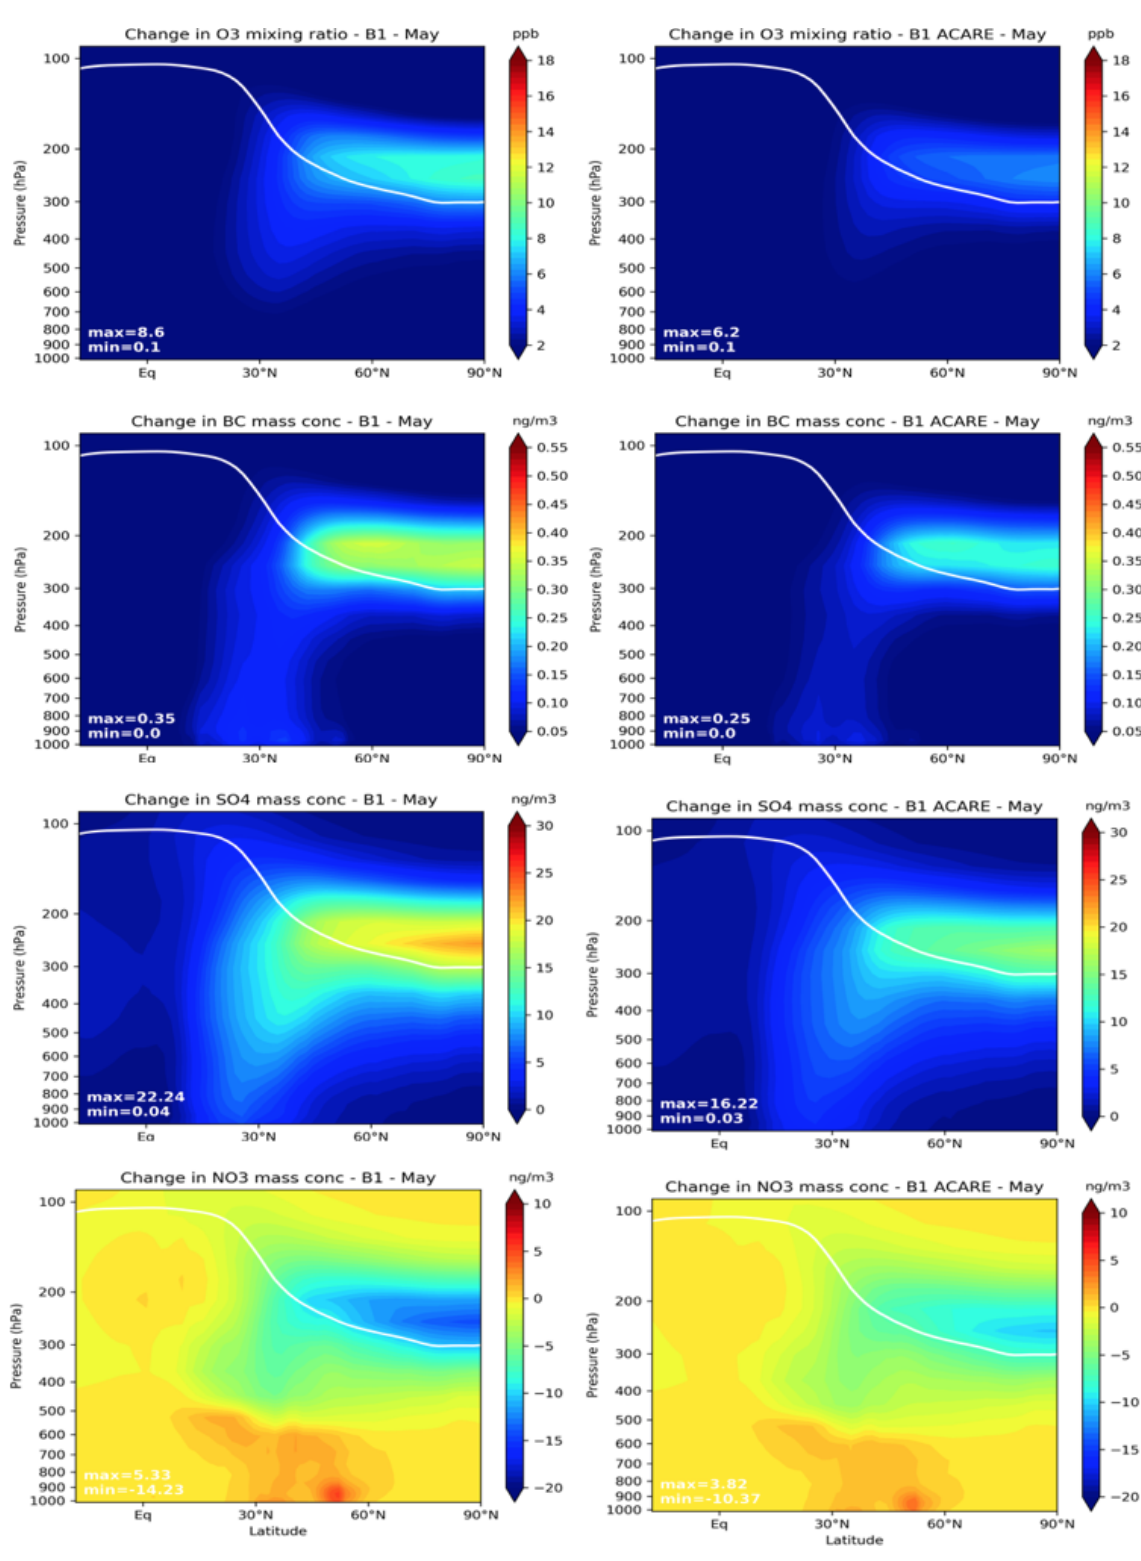
Figure 11. Zonal mean perturbations due to aircraft emissions for May of O 3 (ppbv), BC, SO 4 , and NO 3 (ngm − 3 ) for the QUANTIFY 2050 B1 (left) and B1 ACARE (right) scenarios. The solid line represents the tropopause pressure.